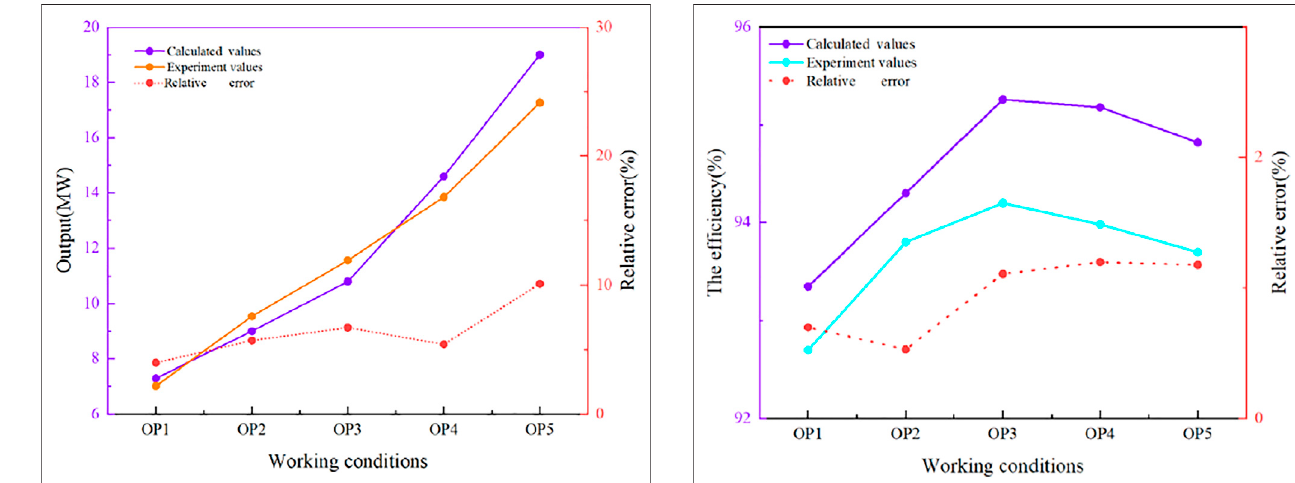
FIGURE 7 | Comparison of ef fi ciency test results and calculated results under fi ve coassociated working